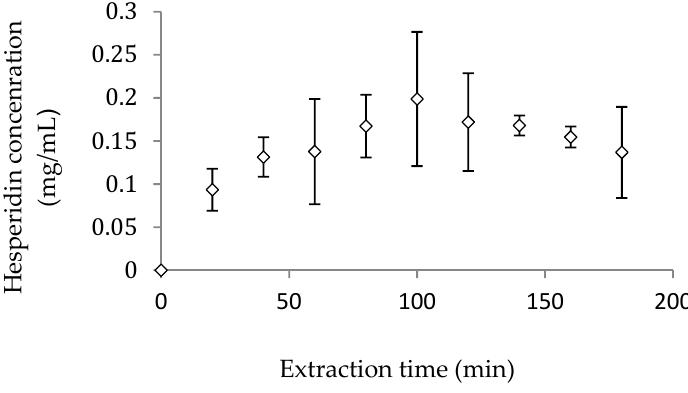
Figure 4. Pilot-scale extraction kinetics .